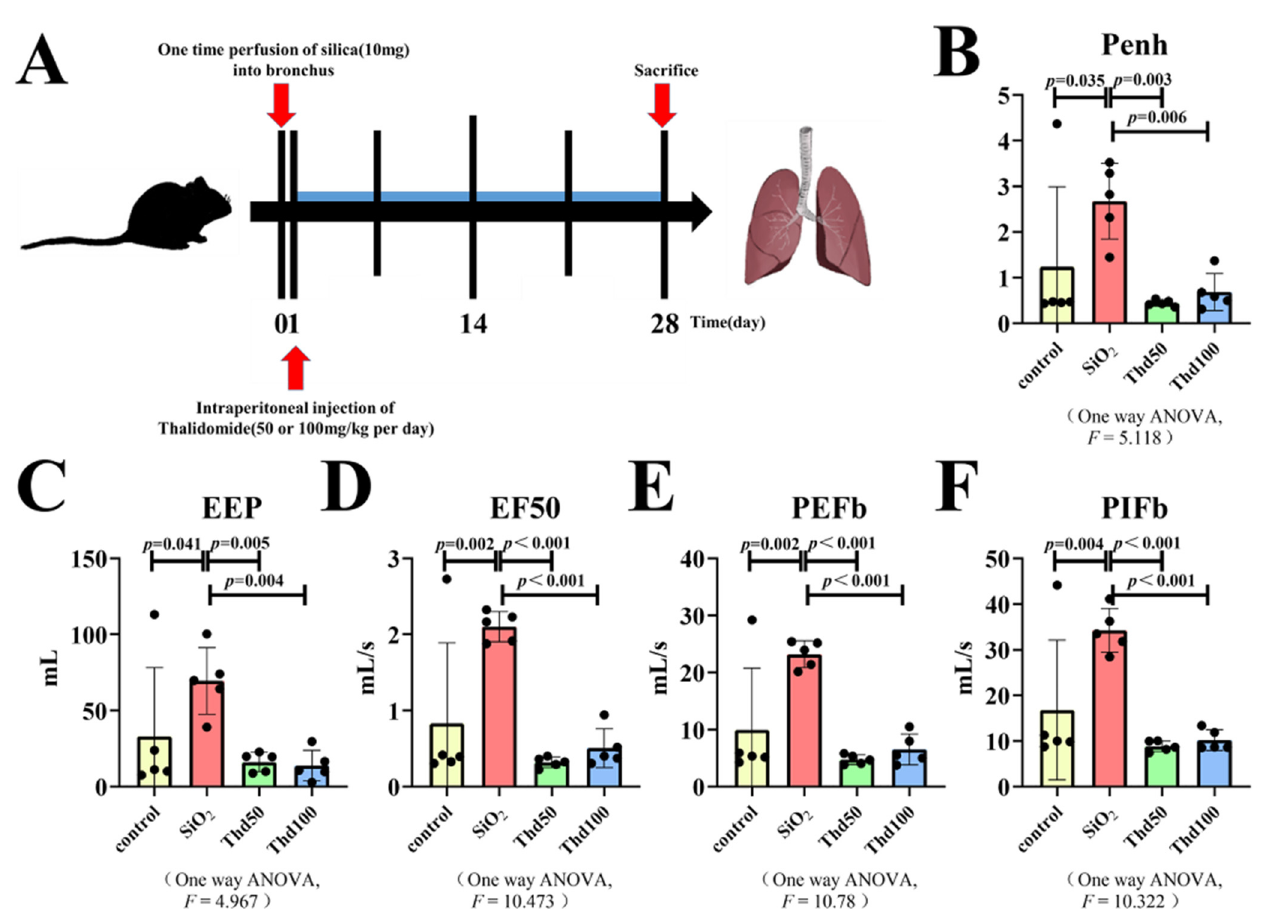
Figure 1. Treatment with the thalidomide overcame the suppression of lung functions in response to silica exposure. ( A ) Schematic of thalidomide administration in therapeutic administration model of silicosis mice. There are four groups (Control, SiO 2 , SiO 2 + thalidomide 50, SiO 2 + thalidomide 100) in the following experiments (8 mice per group). ( B – F ) Lung functions of mice exposed to silica and treated with thalidomide. Data are presented as the mean ± SD. n = 5 per group.